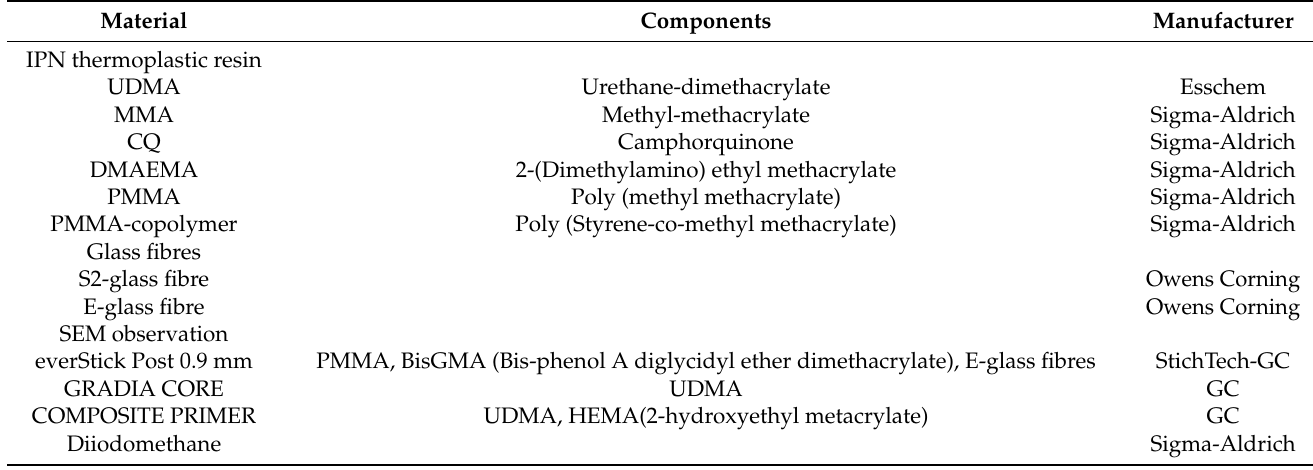
Table 2. Table 1. Materials used in this study.